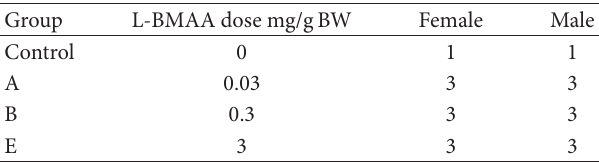
Table 2: Number of brain and liver specimens collected from each mice